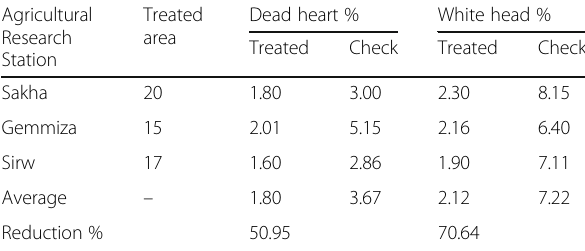
Table 2 Large-scale release of Trichogramma evanescens to control the rice stem borer, Chilo agamemnon , season